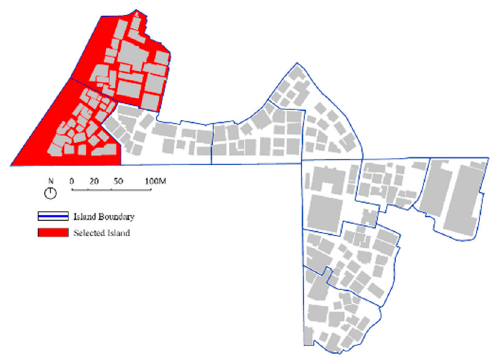
Figure 17. Location of the investigated islands.